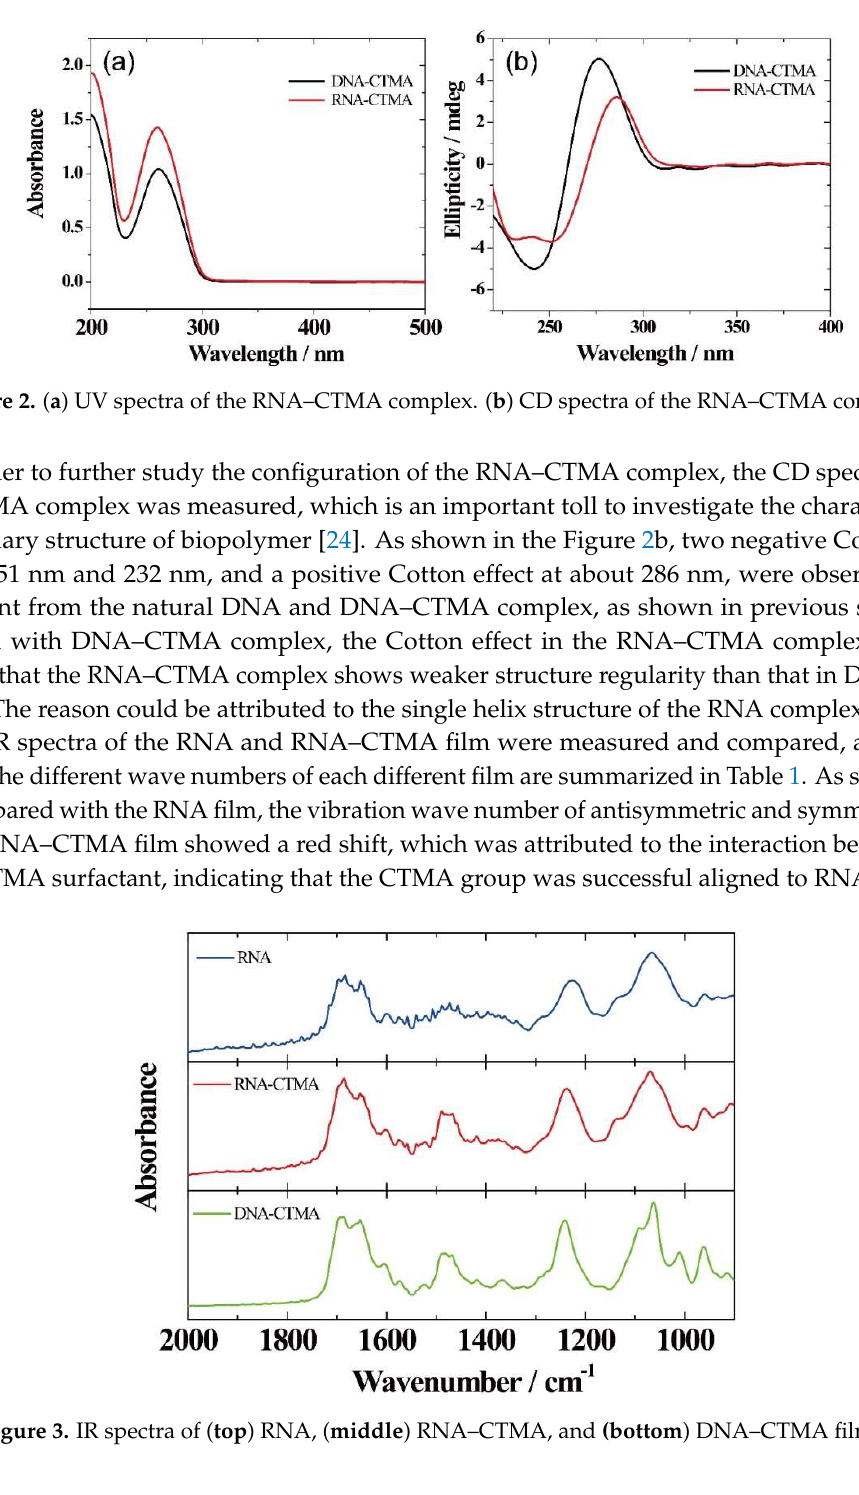
Figure 3. IR spectra of ( top ) RNA, ( middle ) RNA–CTMA, and (bottom ) DNA–CTMA films.